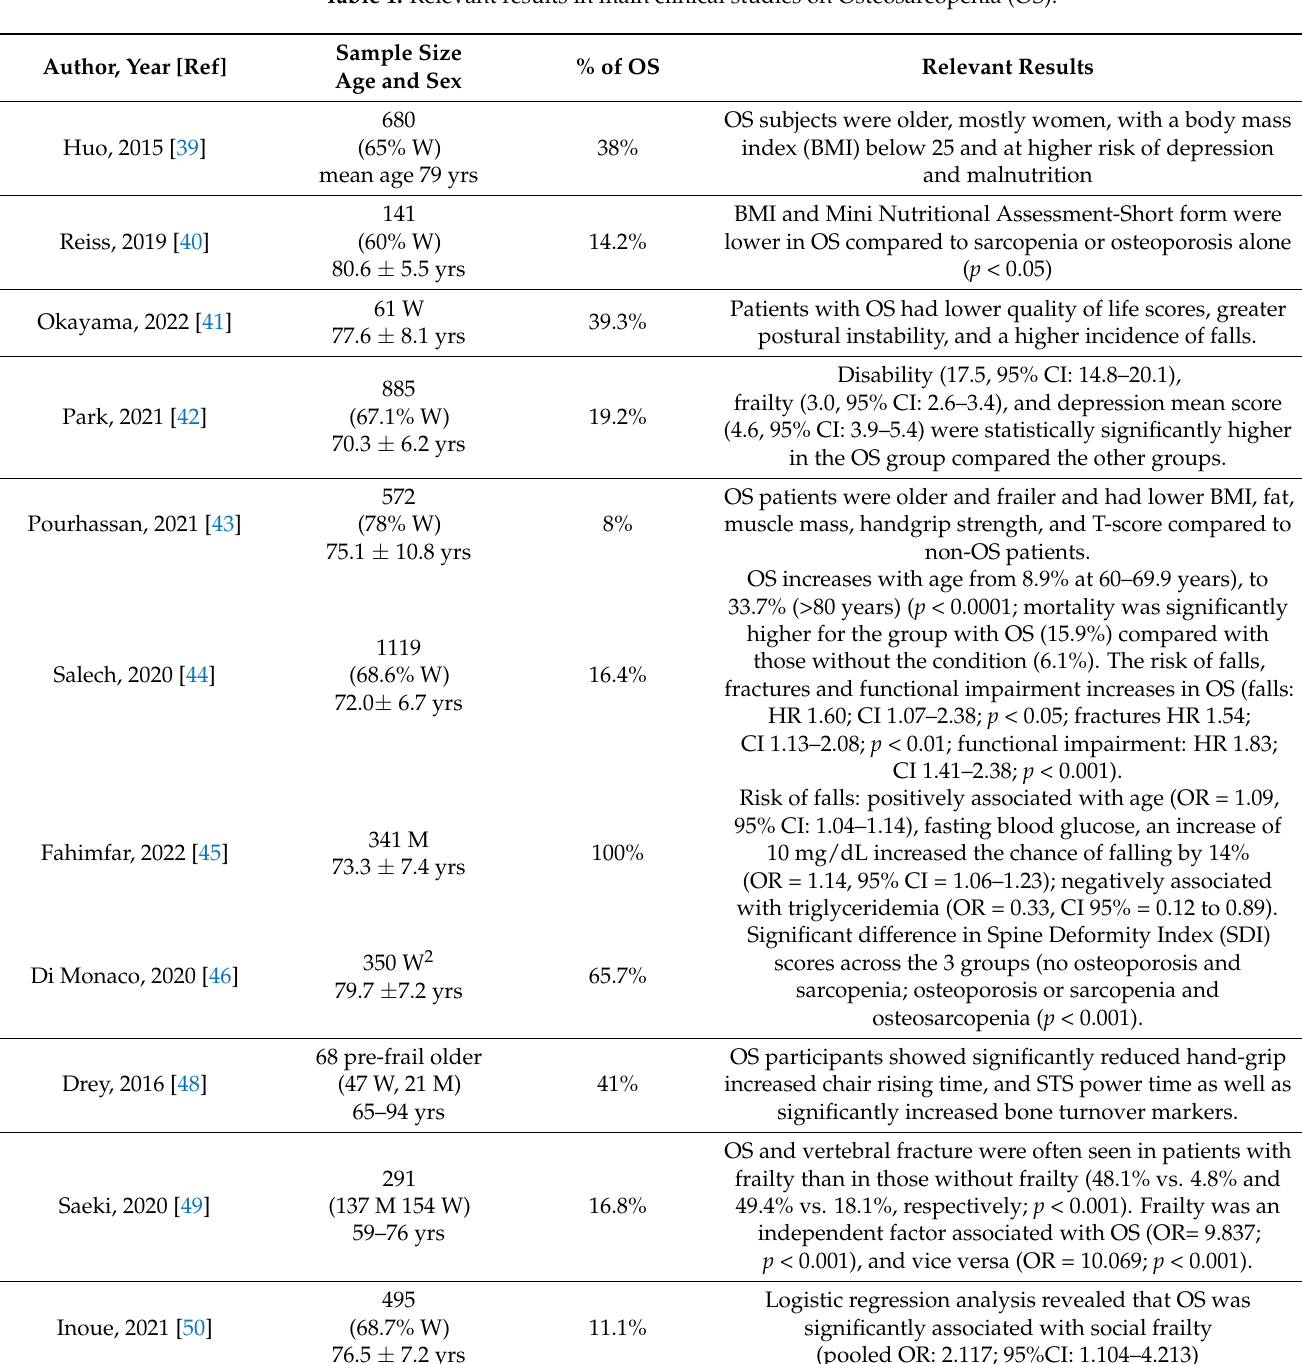
Table 1. Relevant results in main clinical studies on Osteosarcopenia